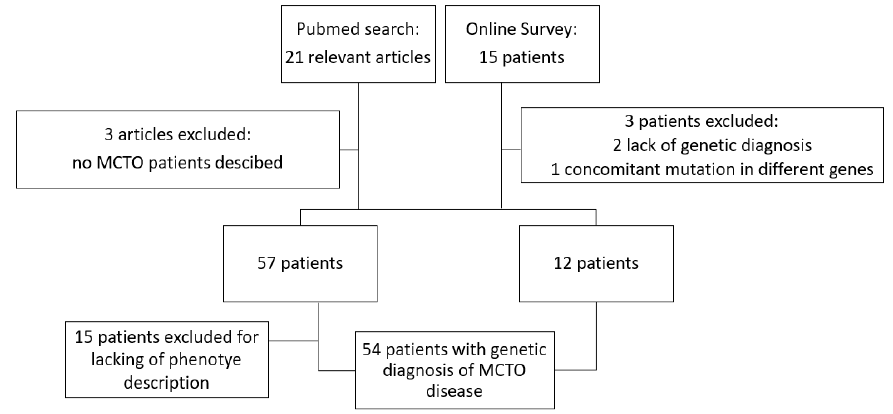
Figure 1. Schematic representation of case selection process.